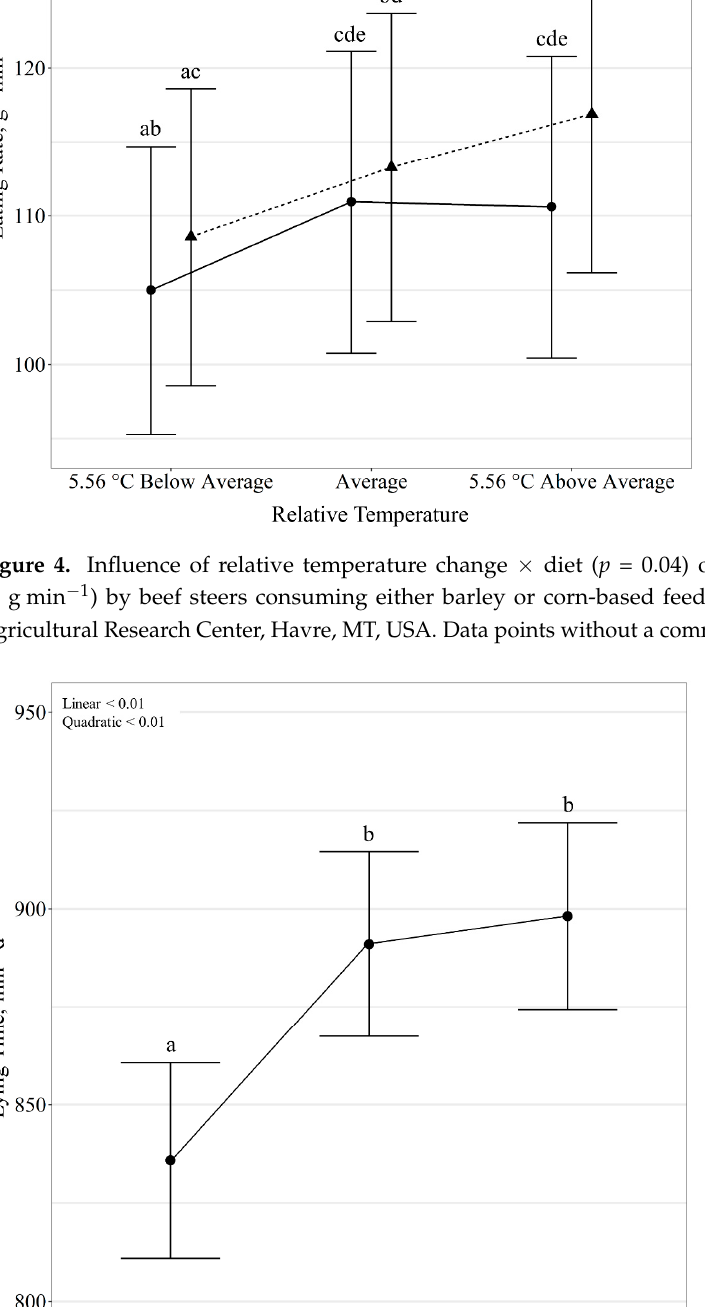
differ ( p = 0.93) between days with average and warmer than the 10-day average temper- ature (Figure 7).